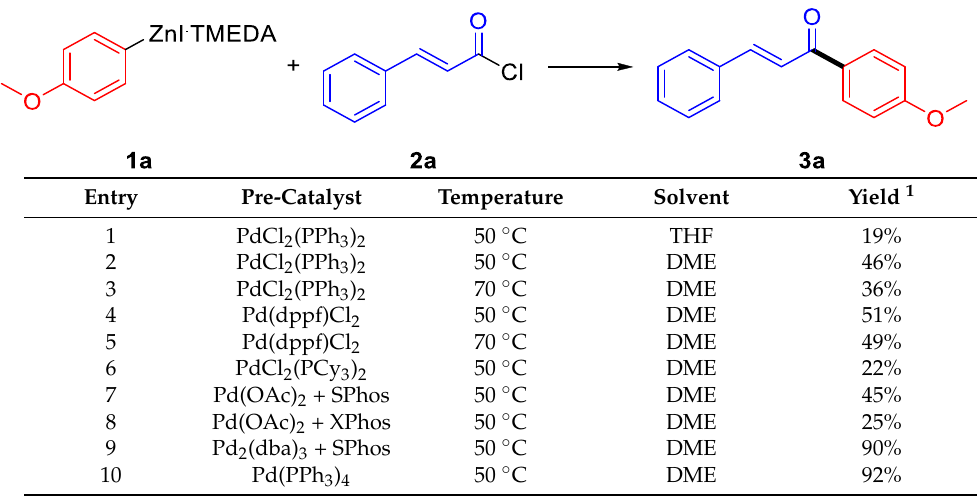
Table 1. Optimization of the model reaction.